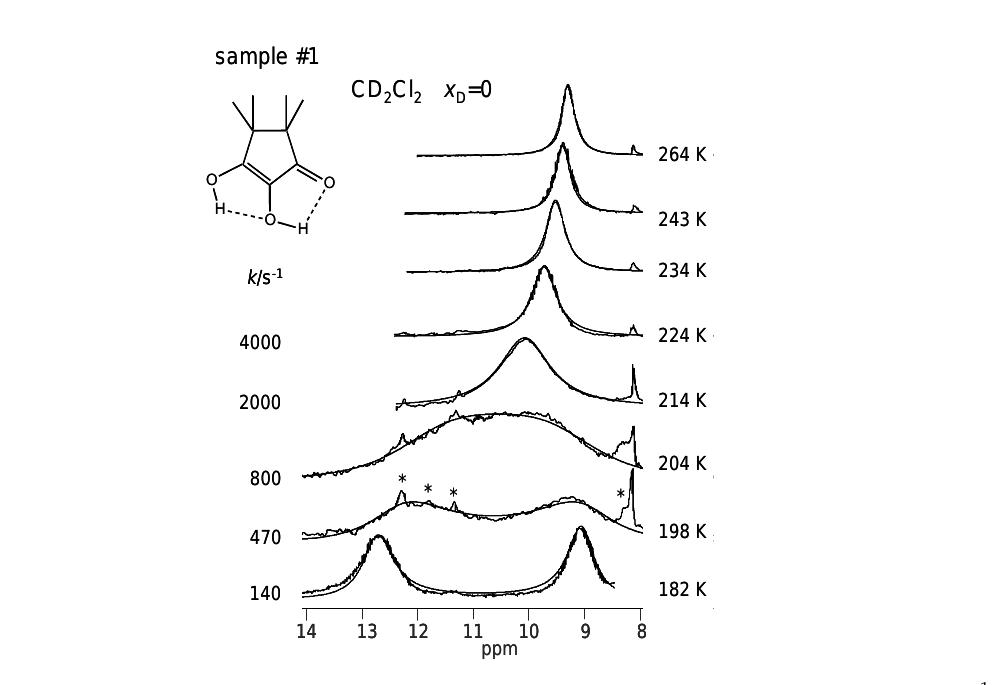
Figure 8. Variable temperature superimposed experimental and simulated 1 H NMR signals of the hydroxyl groups of TMRA dissolved in CD 2 Cl 2 (sample #1). The simulation parameters are assembled in Table 2. The asterisk indicates the presence of an unidentified TMRA decomposition product. For further explanation see text.